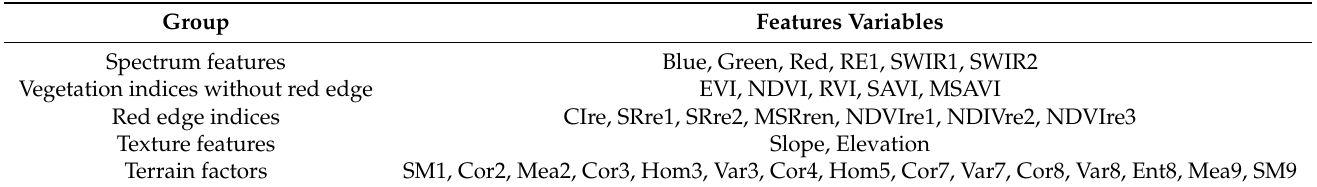
Table 14. Summary of features after preliminary